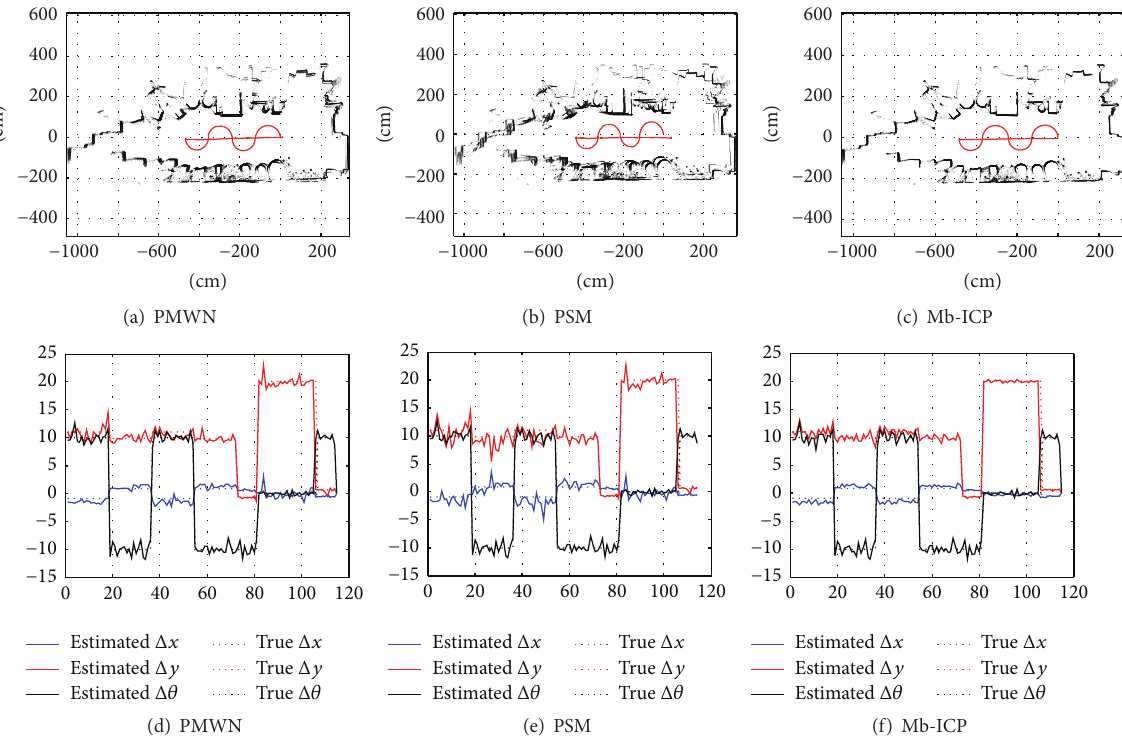
Figure 18: Experiment in laboratory using Series 1 path. ((a), (b), and (c)) The laser sensor is continually placed on footprints of Serial 1 path using PMWN, PSM, and Mb-ICP, respectively, to map laboratory. ((d), (e), and (f)) Compare the pose estimation of PMWN, PSM, and Mb-ICP, respectively, with the true pose in Series 1 path in the